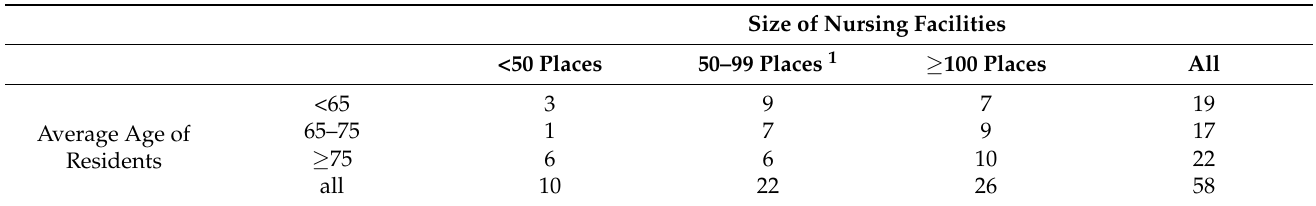
Table 2. Characteristics of responding nursing facilities.